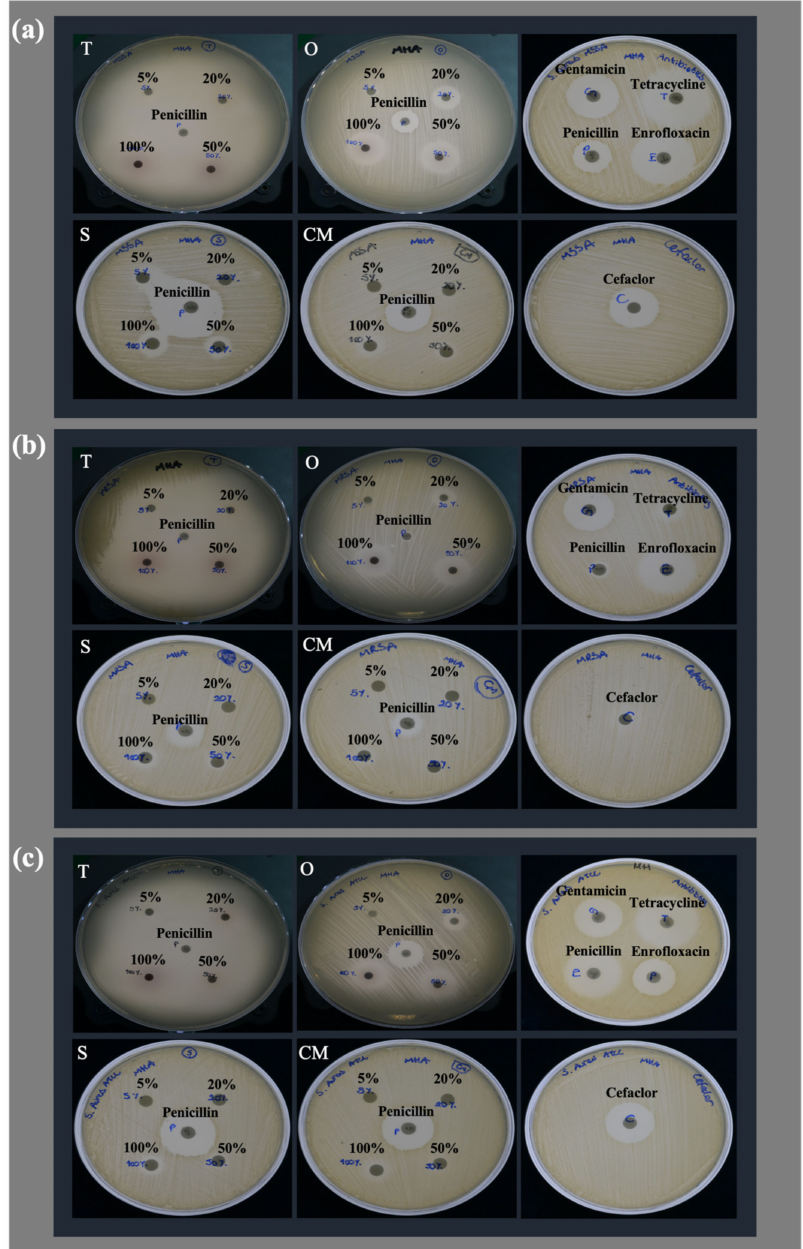
Figure 1. Qualitative illustration of inhibition zone diameters arising from testing EOs with different concentrations and reference antibiotics against ( a ) MSSA, ( b ) MRSA, and ( c ) S. aureus ATCC